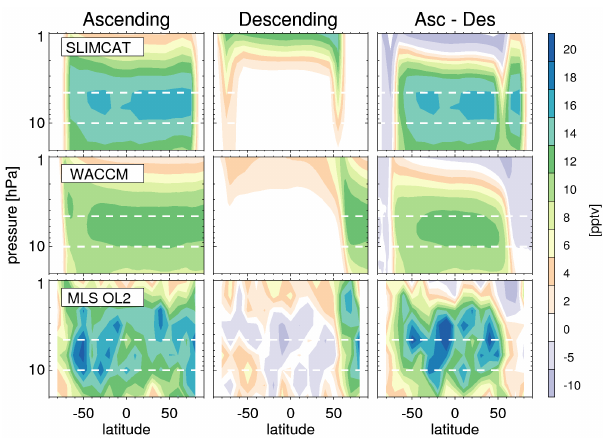
Fig. 9. Photochemical box model simulation of BrO at different pressure levels in the equatorial region computed for